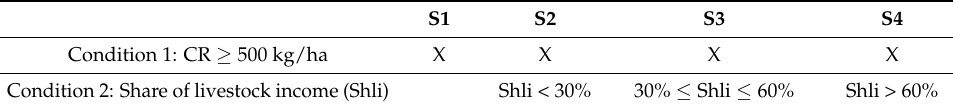
Table 2. Scenario simulations using